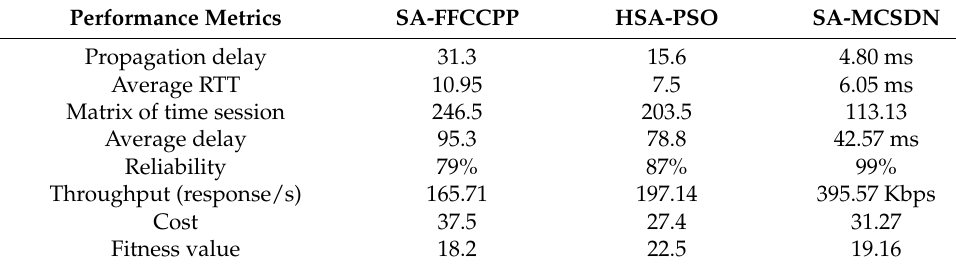
Table 2. Average results of the proposed SA-MCSDN algorithm.